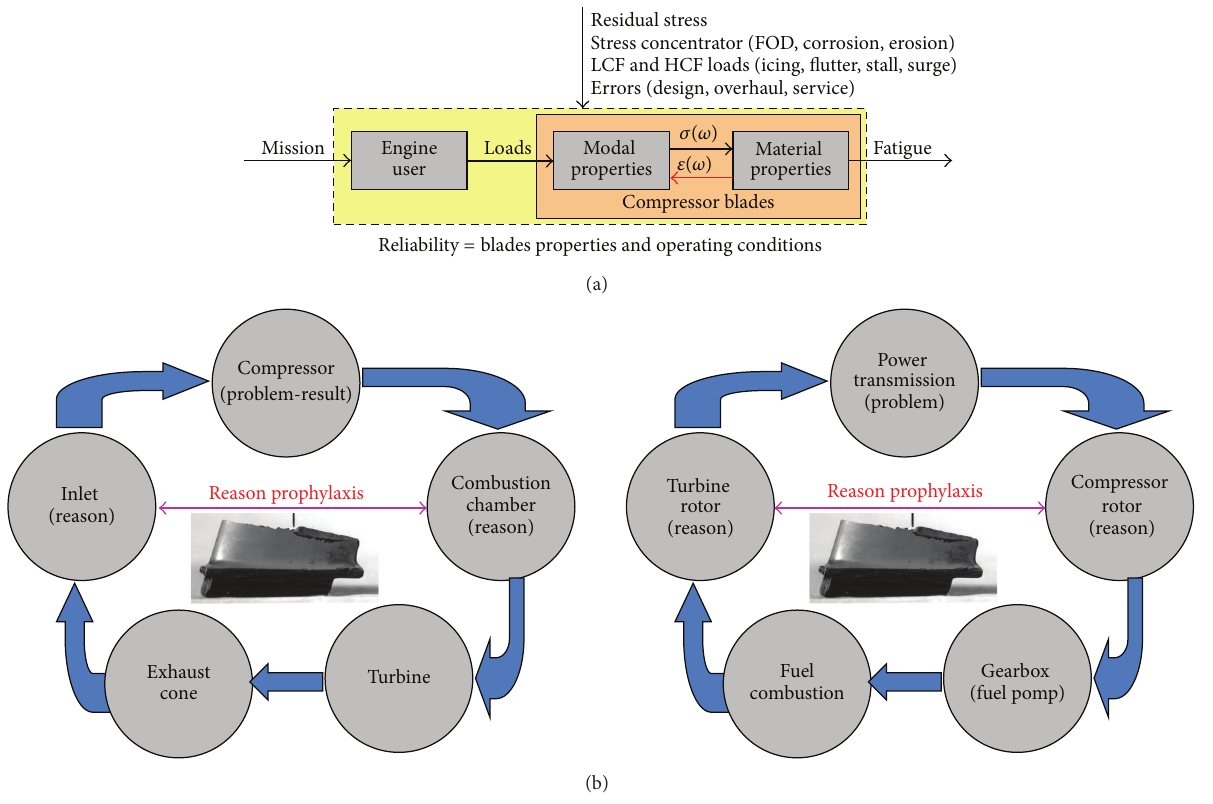
Figure 9: Analysis of cause and effect [3]: (a) classic approach with influence of human and operational factors on fatigue problems of the blades; (b) holistic approach—a compressor blade crack is a “ result ” of the wrong level of energy flow inside the engine. The “ causes ” must be sought at the inlet or the combustion chamber thermodynamic parameters (flow dynamics path) or mechanical power transmission quality and flight loads (kinematic loads